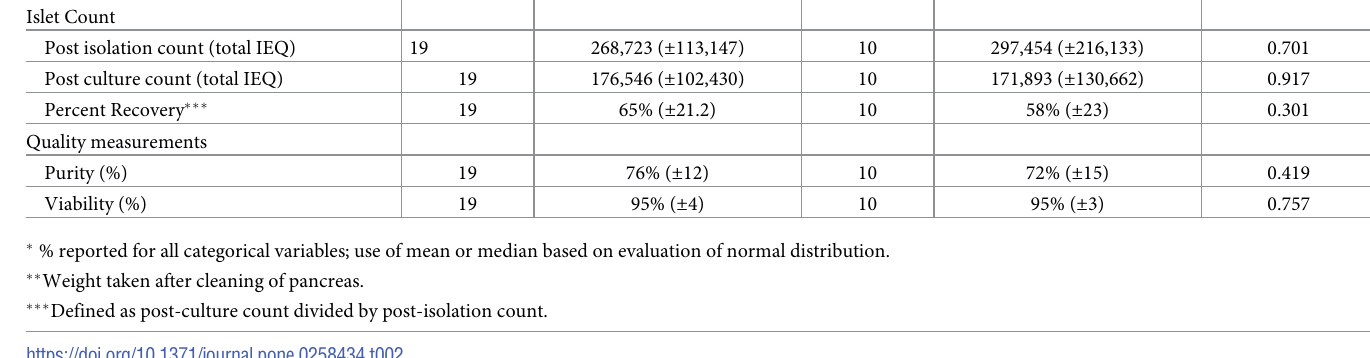
different between marijuana-users and non-users (Table 2). The purity and viability of isolated islets were similar between non-user and marijuana-user groups (Table 2). Islets from mari- juana-users showed decreased insulin secretion following 16.8 mM glucose stimulation (AUC,